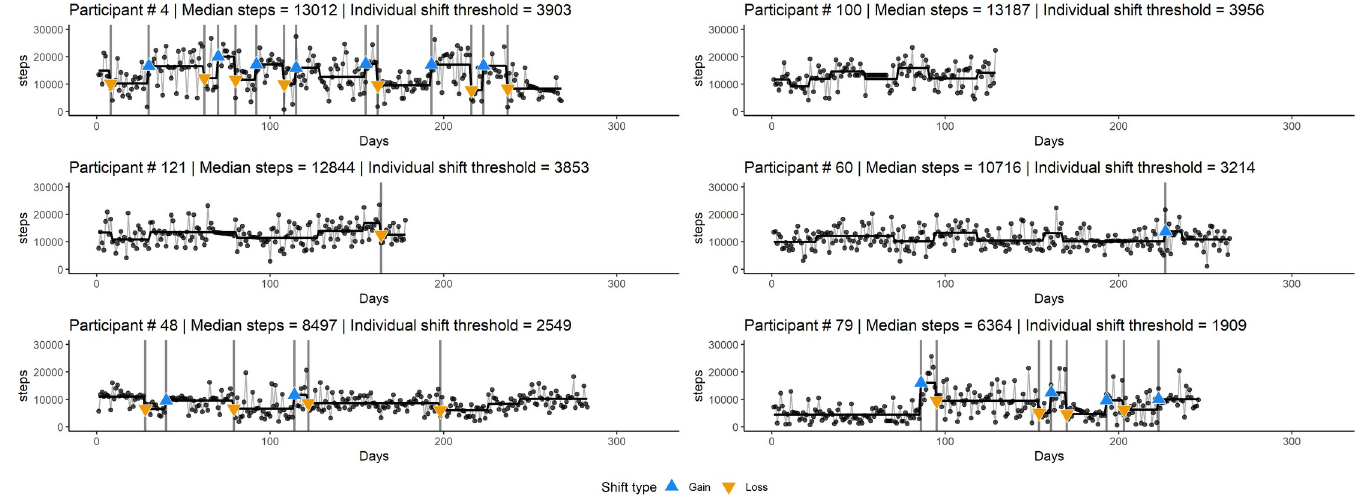
Fig 2. Time series for six participants with heterogeneous patterns of change in walking behavior. Some apparent gains and losses were not classified as “significant” (as indicated by the blue and orange triangles) because they were either smaller than 30% of the median or not preceded and followed by a stable 7-day period.